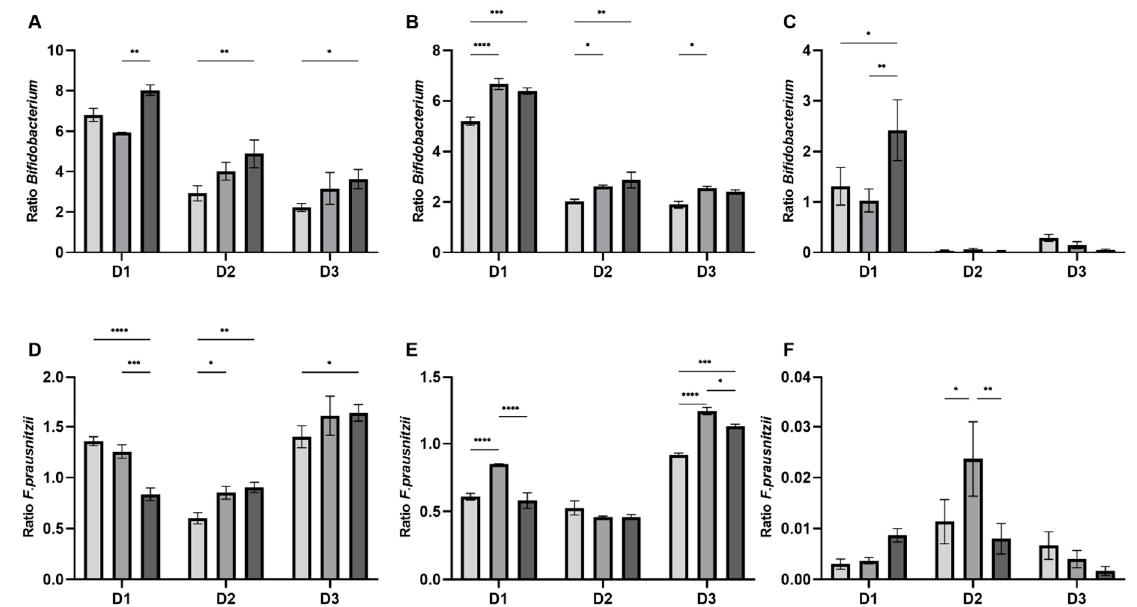
Figure 4. Effect of CG and CGB on specific members of the microbial community. Bars represent the ratio between